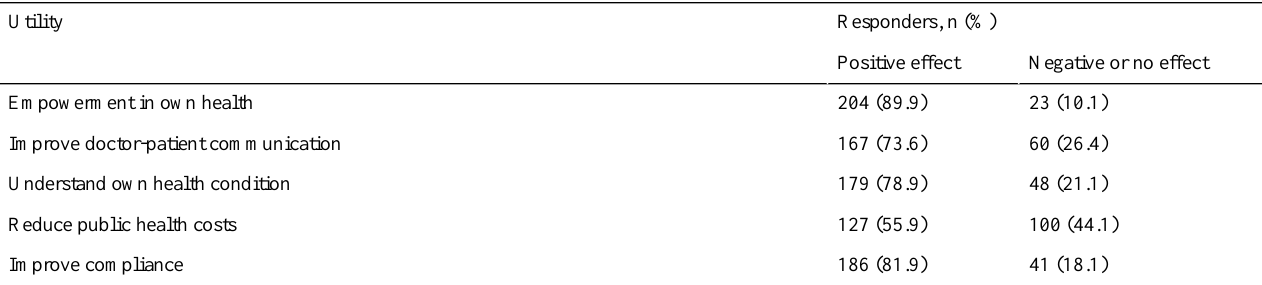
Table 4. Utility of health apps and wearables in health care